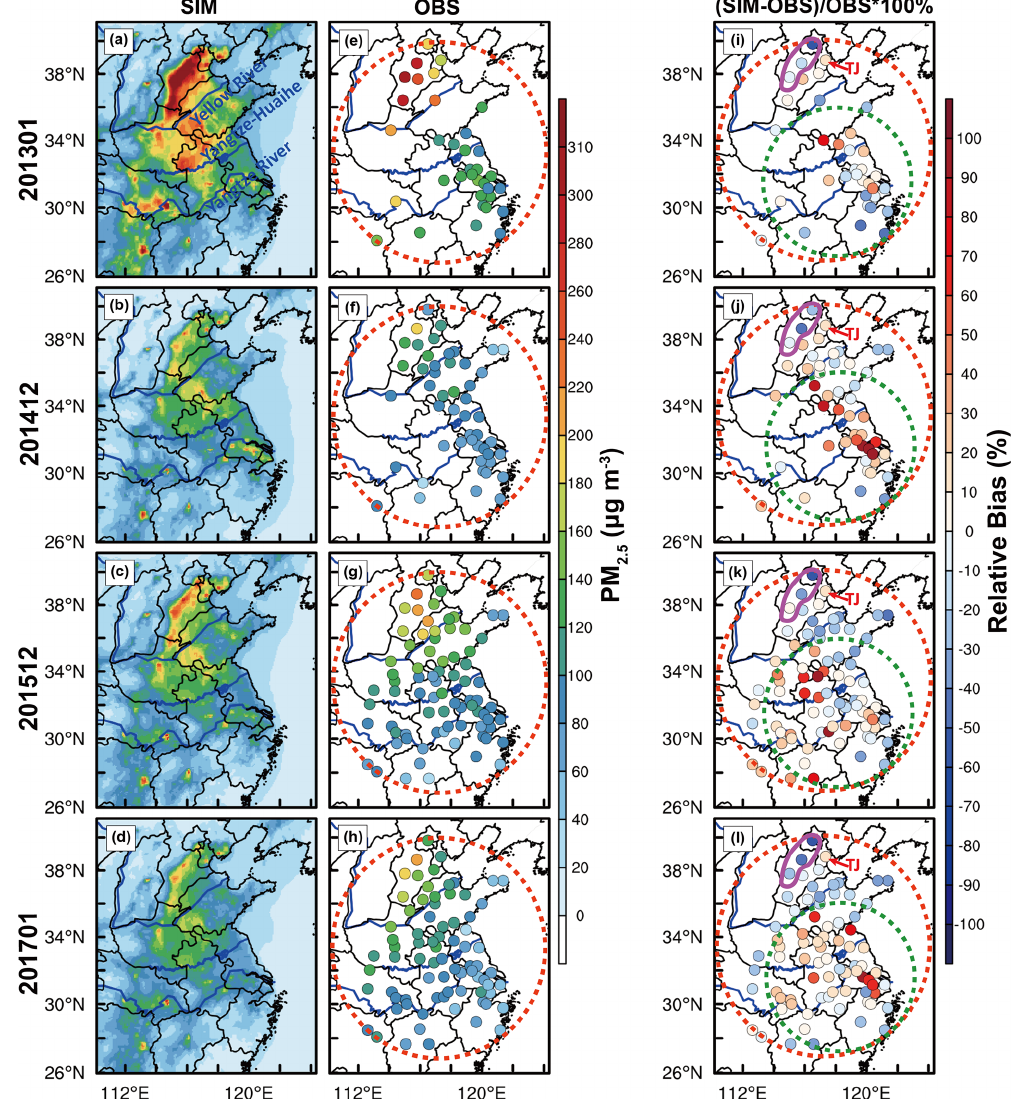
Figure 3. The average value of (a–d) simulated and (e–h) observed PM 2 . 5 concentration (µgm − 3 ) at night and (i–l) the relative bias (RB, %) between simulation and observation. The calculation formula of relative bias is RB = (cid:0) X sim − X obs (cid:1) /X obs × 100%, where X sim and X obs represent the average value of simulation and observation, respectively. The locations of three rivers (i.e., Yellow River, Yangtze–Huaihe and Yangtze River) are marked by blue lines. The dashed red and green circles represent the whole simulation area and eastern China, respectively. The solid purple irregular circle indicates mountainous areas, and “TJ” in red indicates